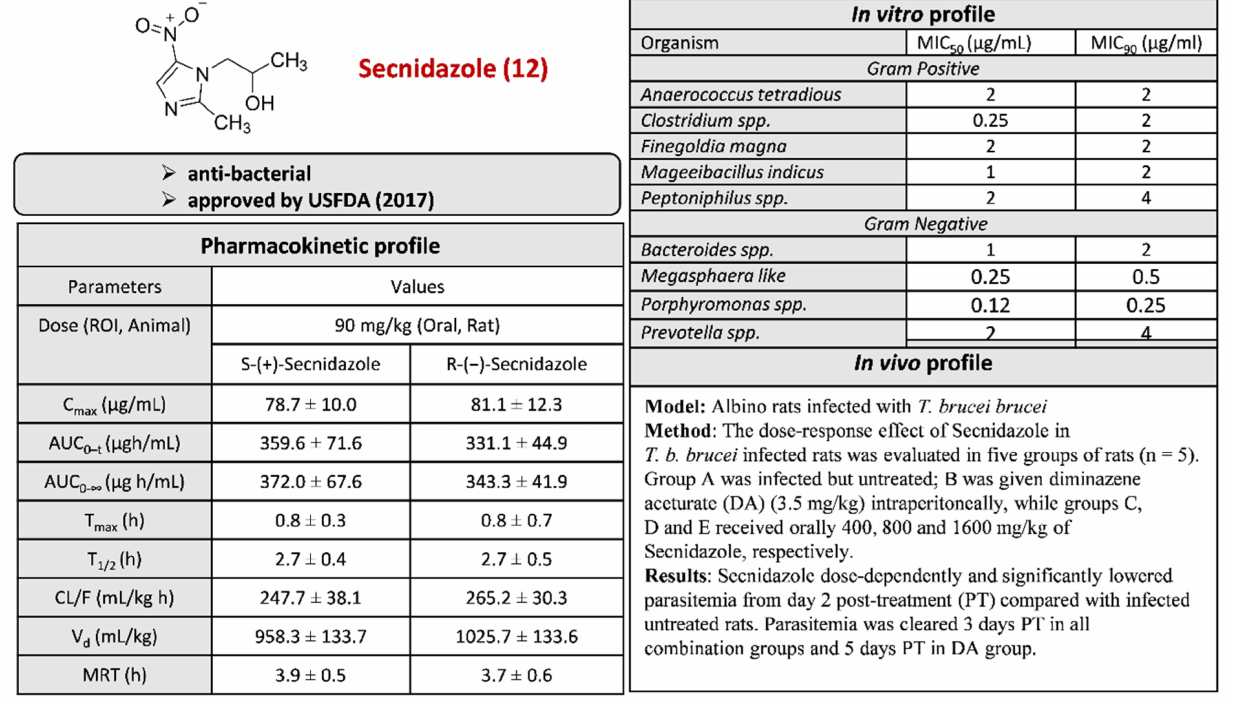
Figure 16. Activity profile of Secnidazole 12